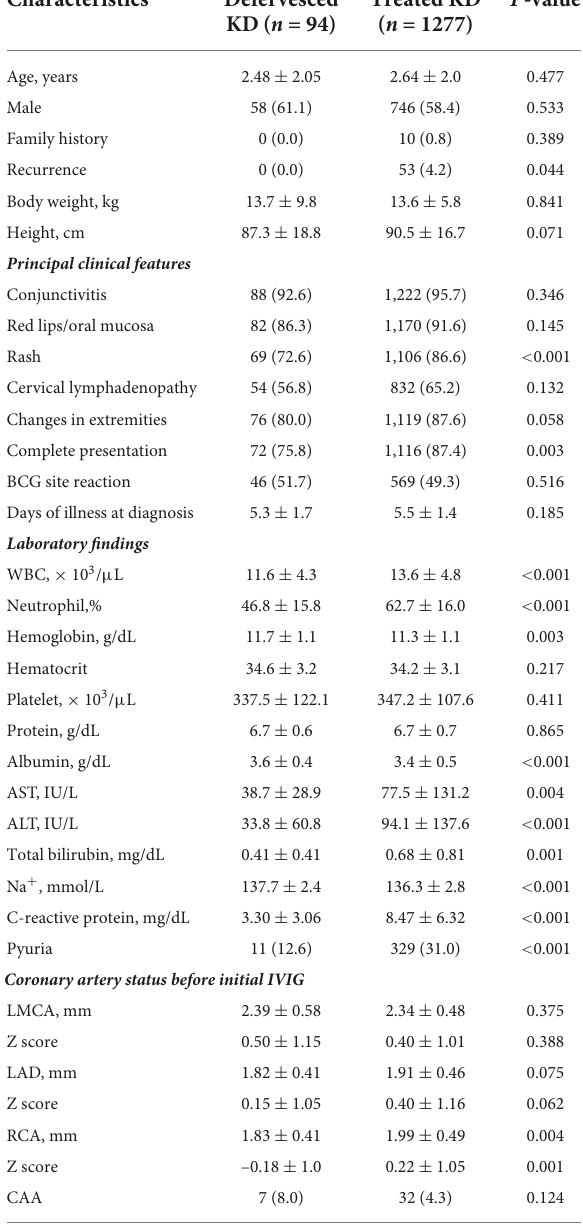
Figure 1 . In the defervesced group, 87 subjects underwent echocardiography during admission, and 7 (8.0%) had a